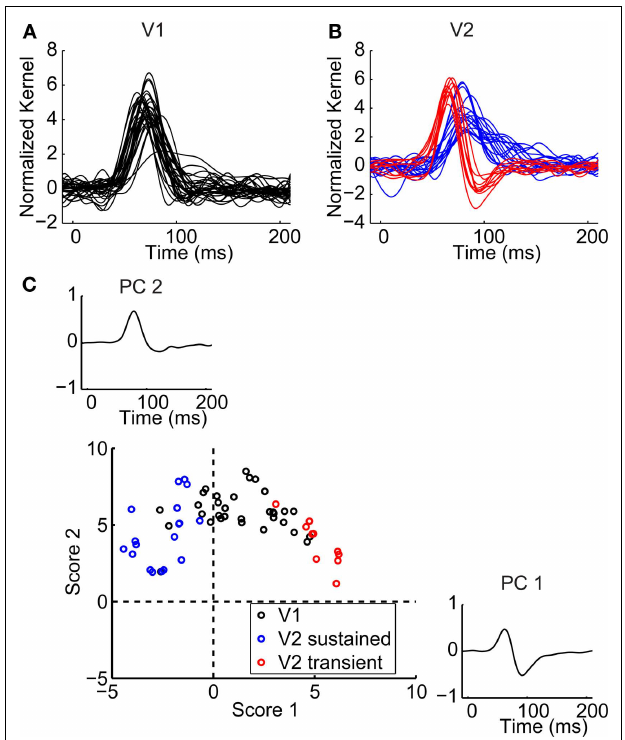
FIGURE 3 | Population summary of fi rst-order kernels. (A) Normalized fi rst-order response kernels of V1 neurons. (B) Normalized fi rst-order response kernels of V2 neurons, monophasic responses are colored blue and biphasic responses red. (C) First and second scores of PCA decomposition of all normalized fi rst-order kernels. The principal components are plotted in insets along the corresponding axes. V1 kernels are colored in black; biphasic V2 kernels (fi rst score larger than 0) in red; monophasic V2 kernels (fi rst score smaller than 0) in